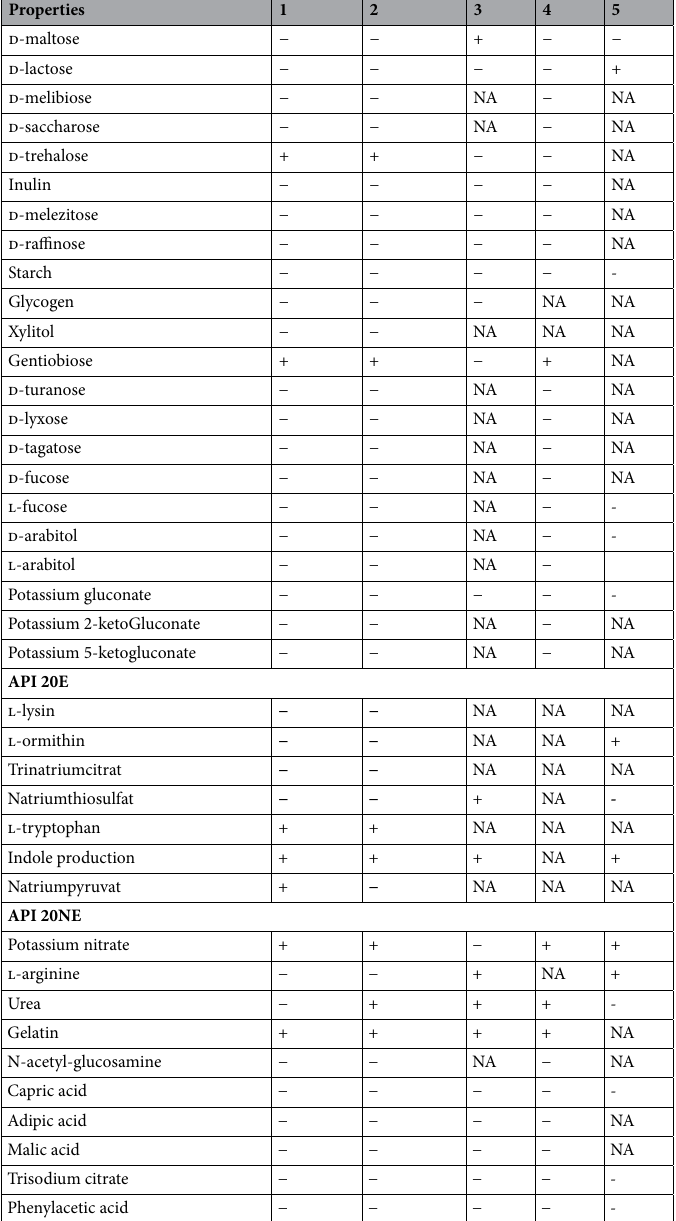
Table 5. Biochemical characteristics of Marseille-P9602 and phylogenomically related species. Taxa: 1, Marseille-P9602; 2, C. scophthalmum ; 3, C. indoltheticum ; 4, C. piscium ; 5, C. balustinum. The results presented for 1 and 2 are those obtained in the present study. The results presented for 3, 4 and 5 were completed using previously published studies 54,55,74 . positive (+); negative (−); NA, non-available. Marseille-P9602 strain differs from C. scophthalmum , C. indoltheticum , C. piscium , and C. balustinum regarding catalase, α-glucosidase, inositol and